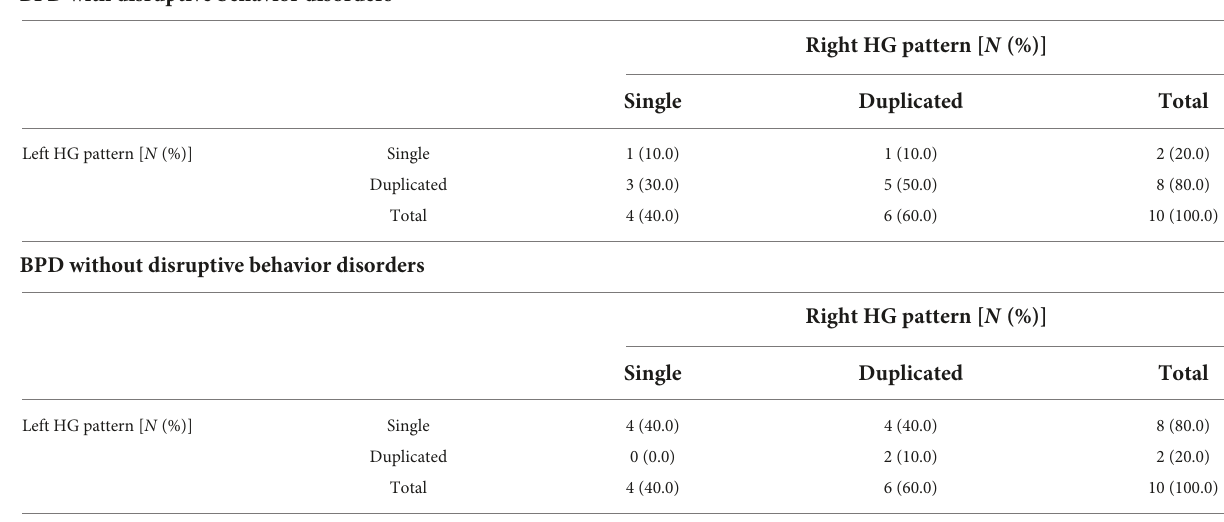
TABLE 3 Gyrification pattern of Heschl’s gyrus (HG) in borderline personality disorder (BPD) patients with and without comorbid disruptive behavior disorders. BPD with disruptive behavior